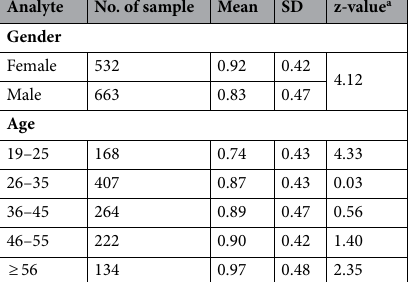
Table 3. Results of the Z-test for gender and age groupings. a Harris & Boyd’s Z-test was used for gender grouping, resulting in one z-value; weighted alternative approach was used for age grouping, resulting in one z-value per group; The value of z* is 6.69.